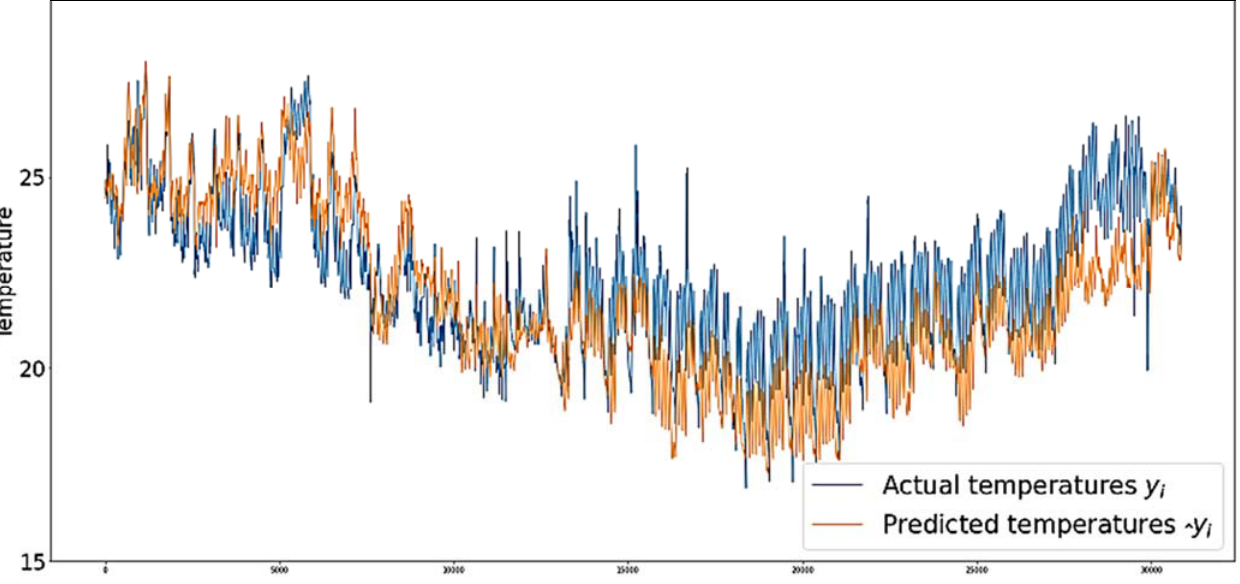
Figure 22. Plot of actual and predicted temperatures 24 h ahead for office 40 on the second floor.